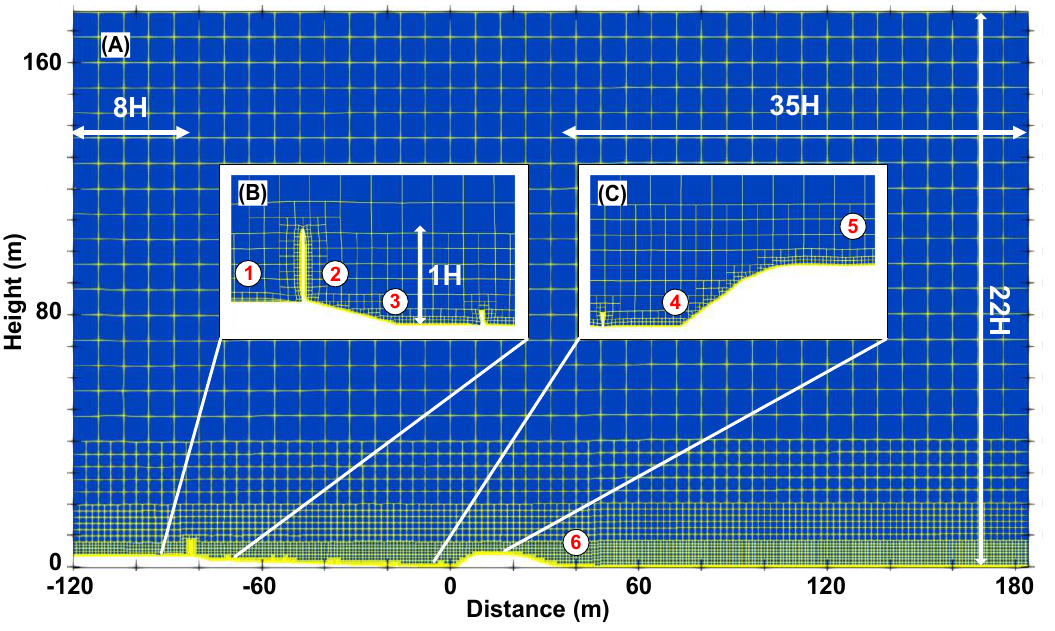
Figure 2. Overview of the meshing from the front of the domain ( A ), with a zoom on the precast noise barrier atop of a berm here located upwind to the source ( B ) and a zoom on the flat-top earth-berm located downwind to the source ( C ). Numbers in red show the locations of the vertical profiles at which the PM2.5 concentrations are